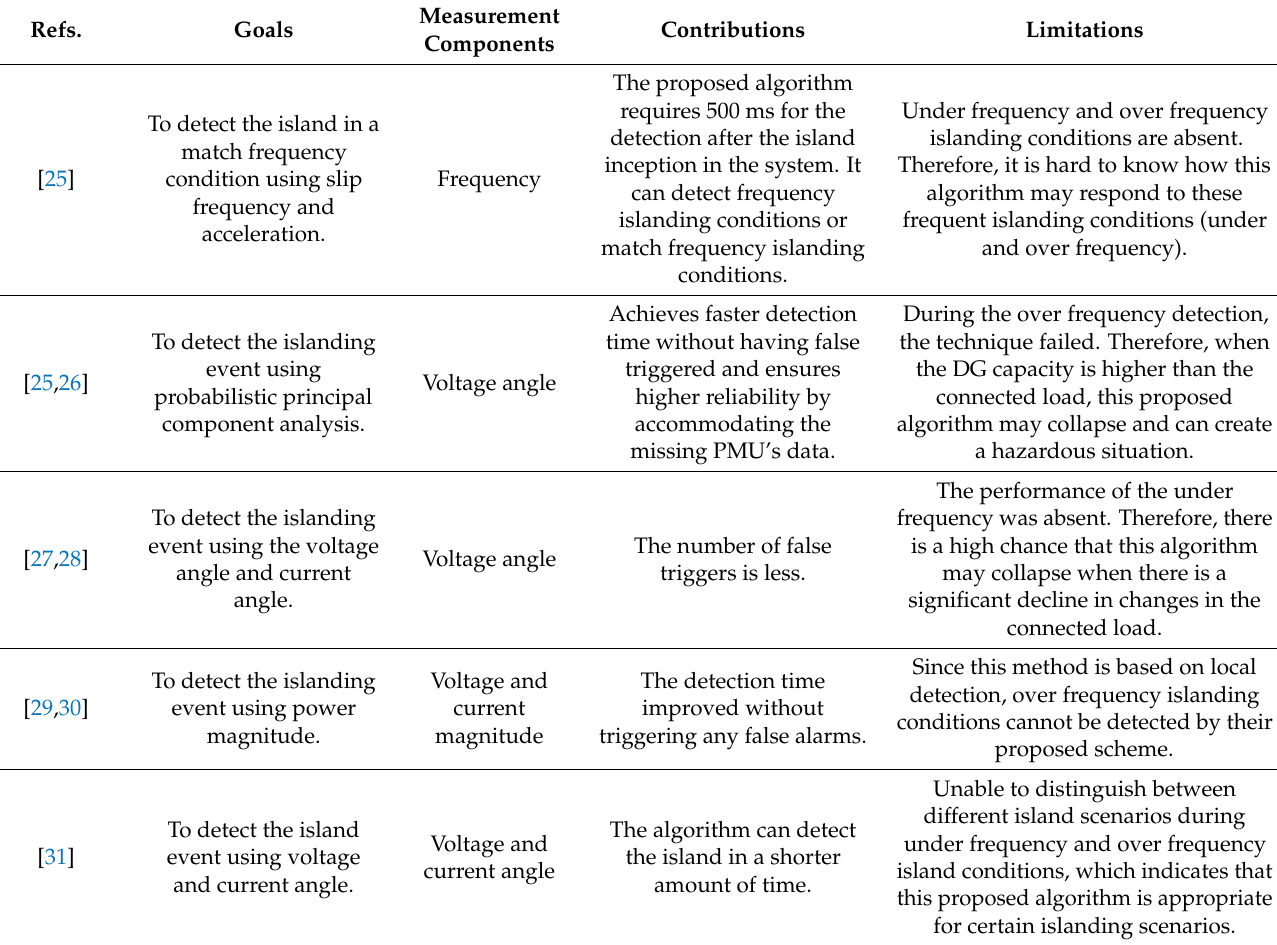
Table 1. Existing island detection techniques, contributions, and